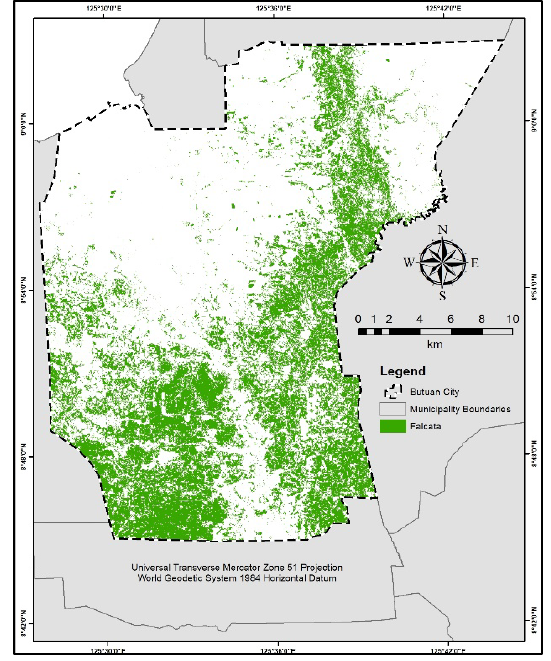
Figure 2. Mapped Falcata Plantations in Butuan City.